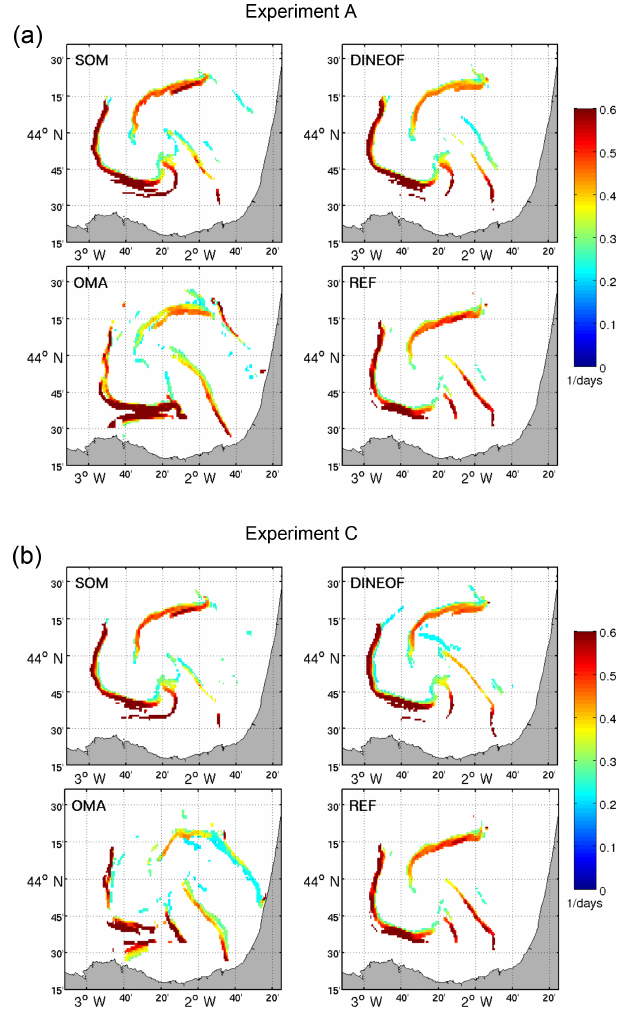
Figure 10. Snapshots of attracting LCS computed from the three filled and the reference HFR currents for experiment A (a) and ex- periment C (b) corresponding to 11 April 2014, 00:00UTC.